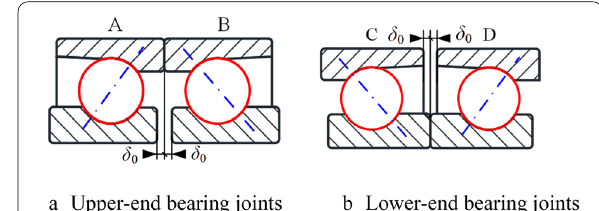
Figure 4 Structural schematic diagram